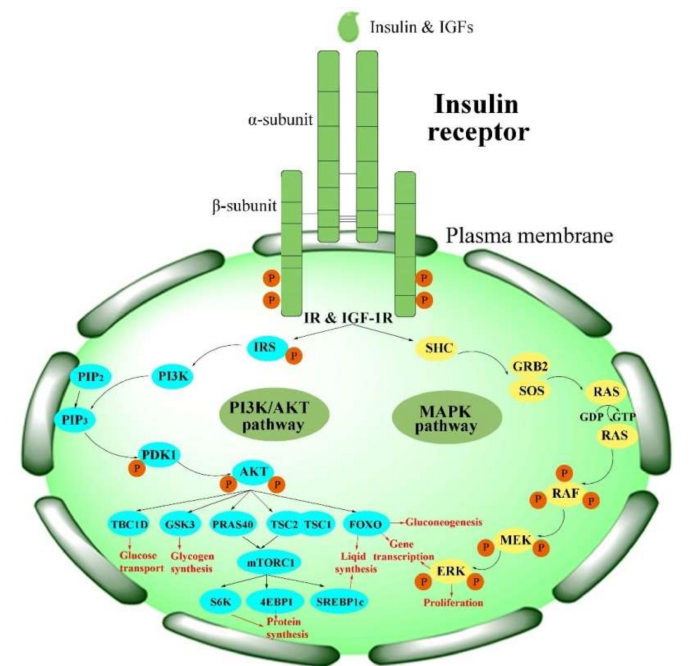
Figure 2. Activation of the IR in insulin signaling pathways. PI3K/AKT pathways: phosphatidylinositol- 3-kinase signaling pathways; MAPK pathway: mitogen-activated protein kinase